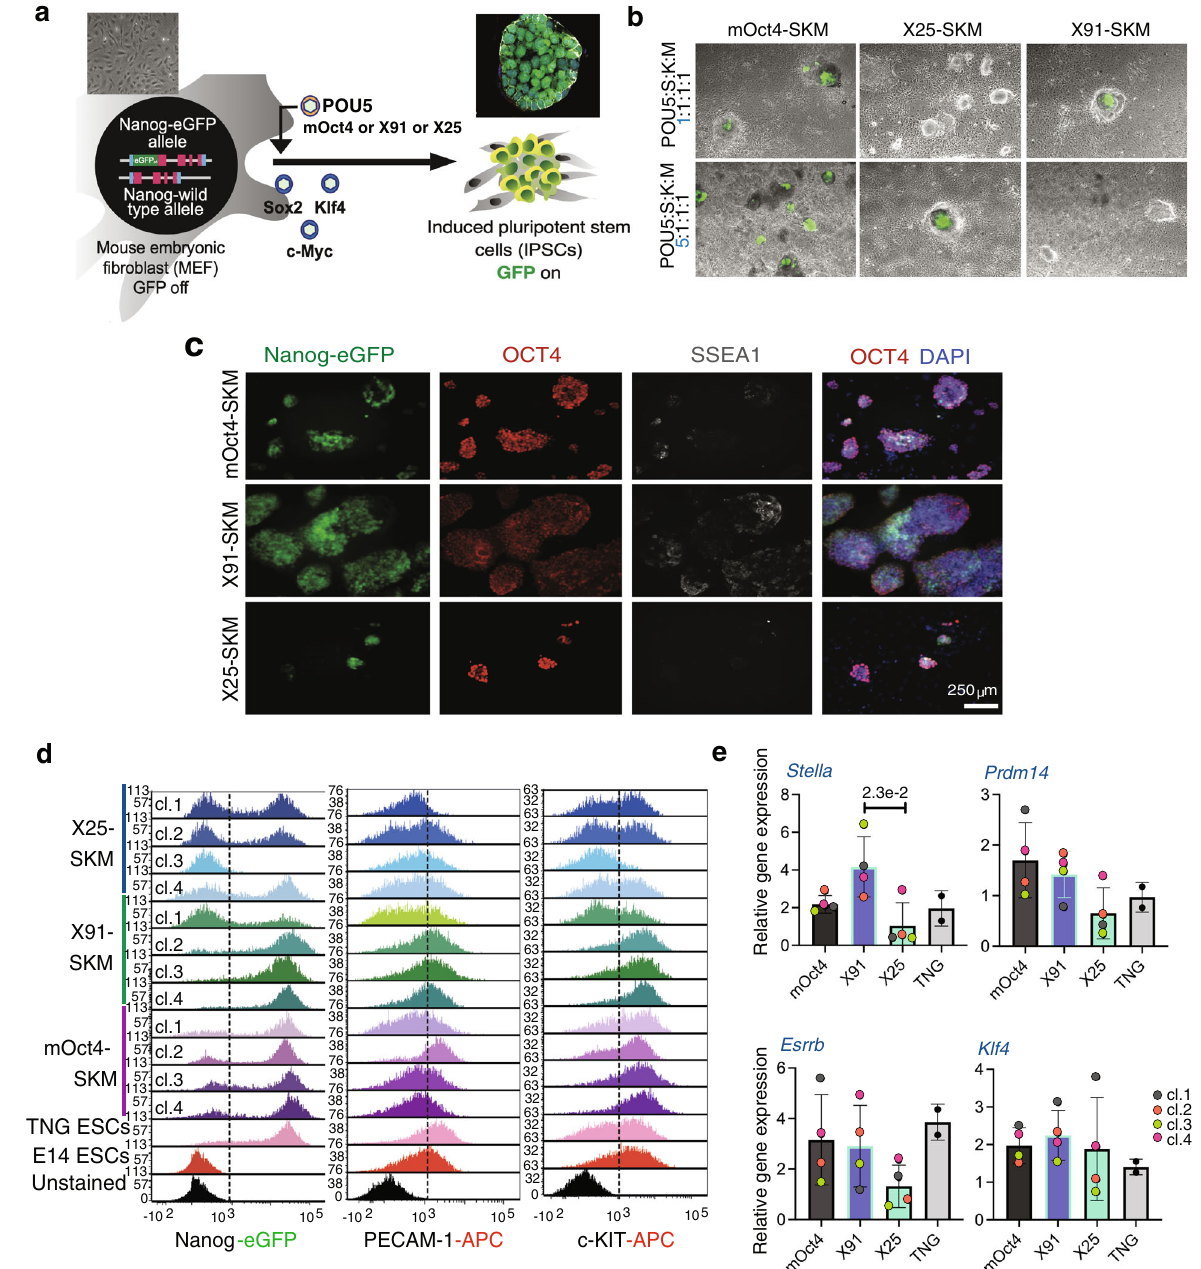
Fig. 4 | Duplicate POU5 homologues fromfrog display segregated functions in pluripotency establishment. a Experimental strategy used for murine iPSCs generation by retrovirus-based approach. Nanog-GFPmouse fi broblasts wereused as a source of somatic cells to monitor the emergence of pluripotency (Nanog positive/green). Oct4 inOSKMcocktailwasreplacedwitheitherfrogX25orX91and eitherloworhightitreofviralinfection(for Oct4 homologues). b Mergedimagesof bright fi eld and Nanog-GFP represent iPSC colonies at day 24 post-infection. c Characterisation of Xenopus POU5s and mOct4-derived iPSC clonal lines by immuno fl uorescence. Anti-Oct4 and anti-SSEA1 antibodies were used to detect a